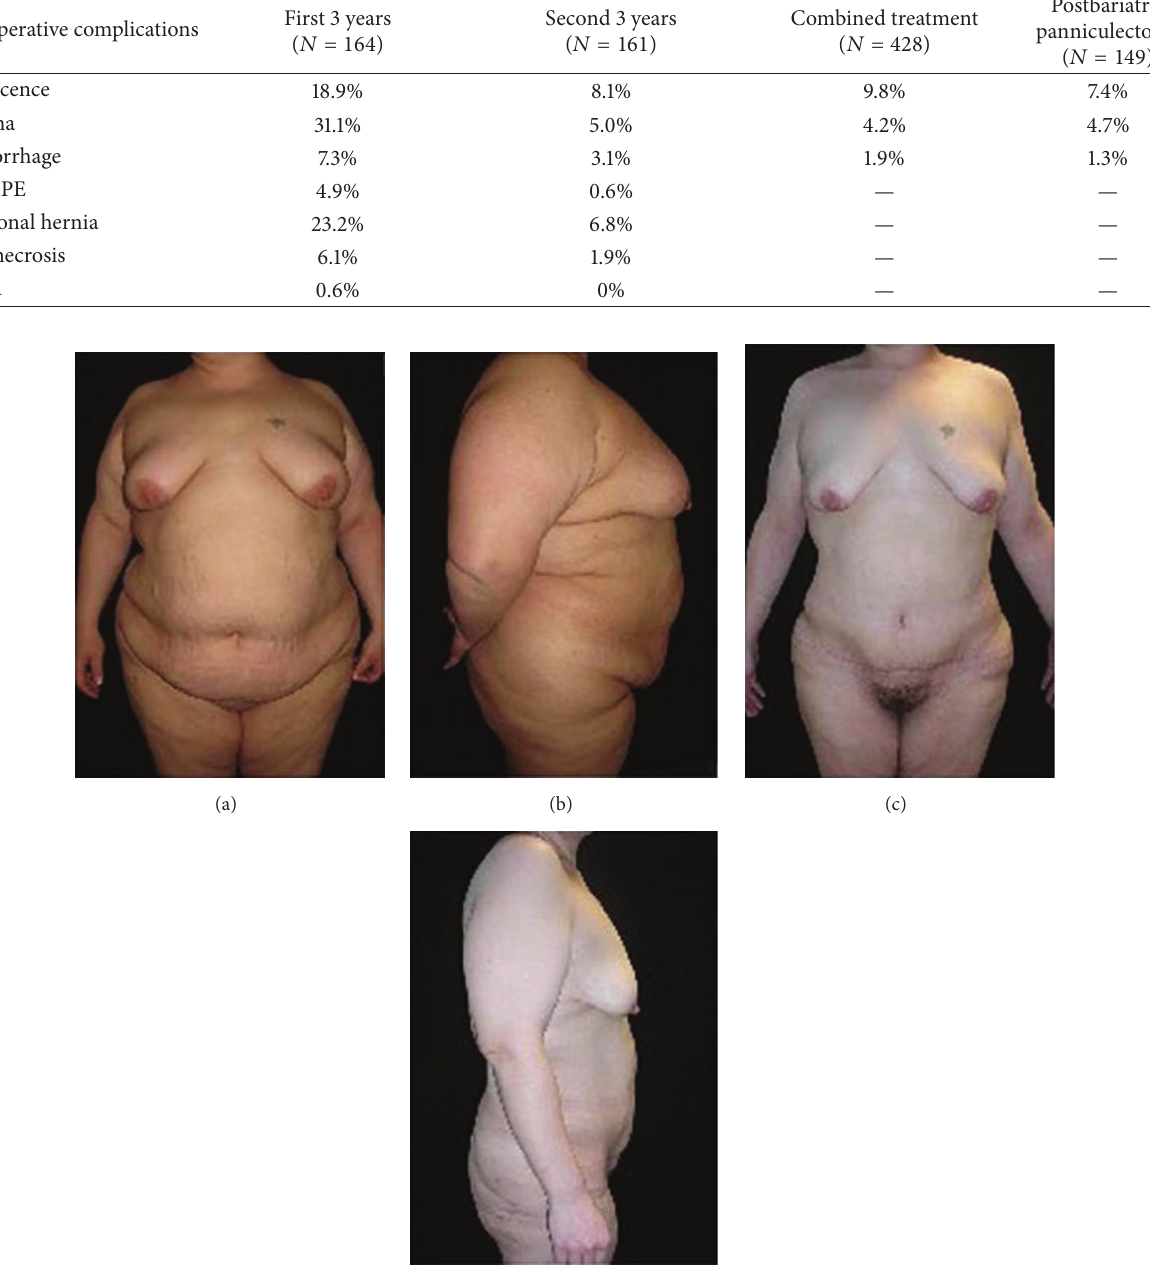
Table 6: Comparison of postoperative complications found in this study in the first and second 3-year periods with those reported in a previous study [9].